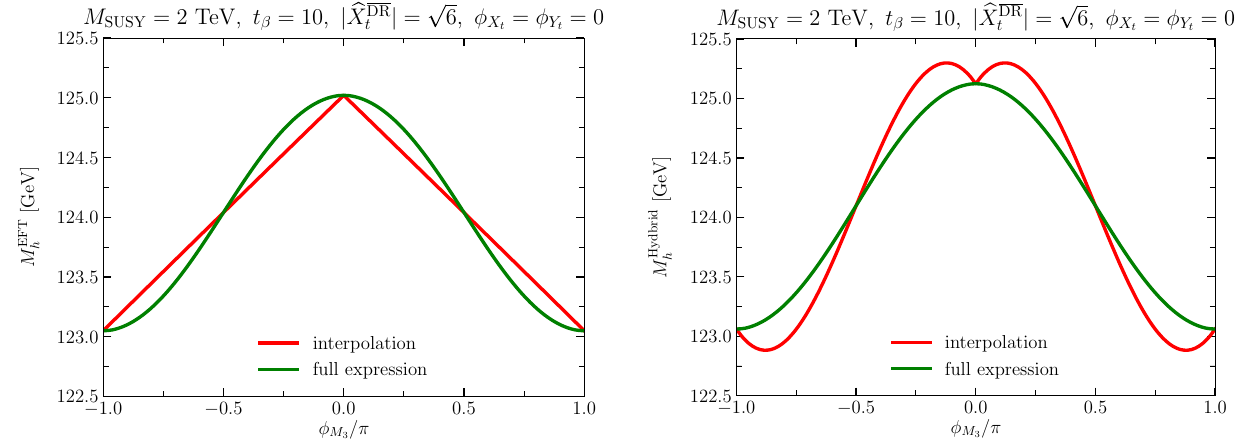
= φ = 0calculatedusingthepureEFTcalculation.Theresultsobtainedbyusinganinterpolation Fig. 5 Left: M h asafunctionof φ M setting φ X Y t t 3 of the phase and by including the full phase dependence are compared. Right: Same as left plot, but the results of the hybrid calculation are shown